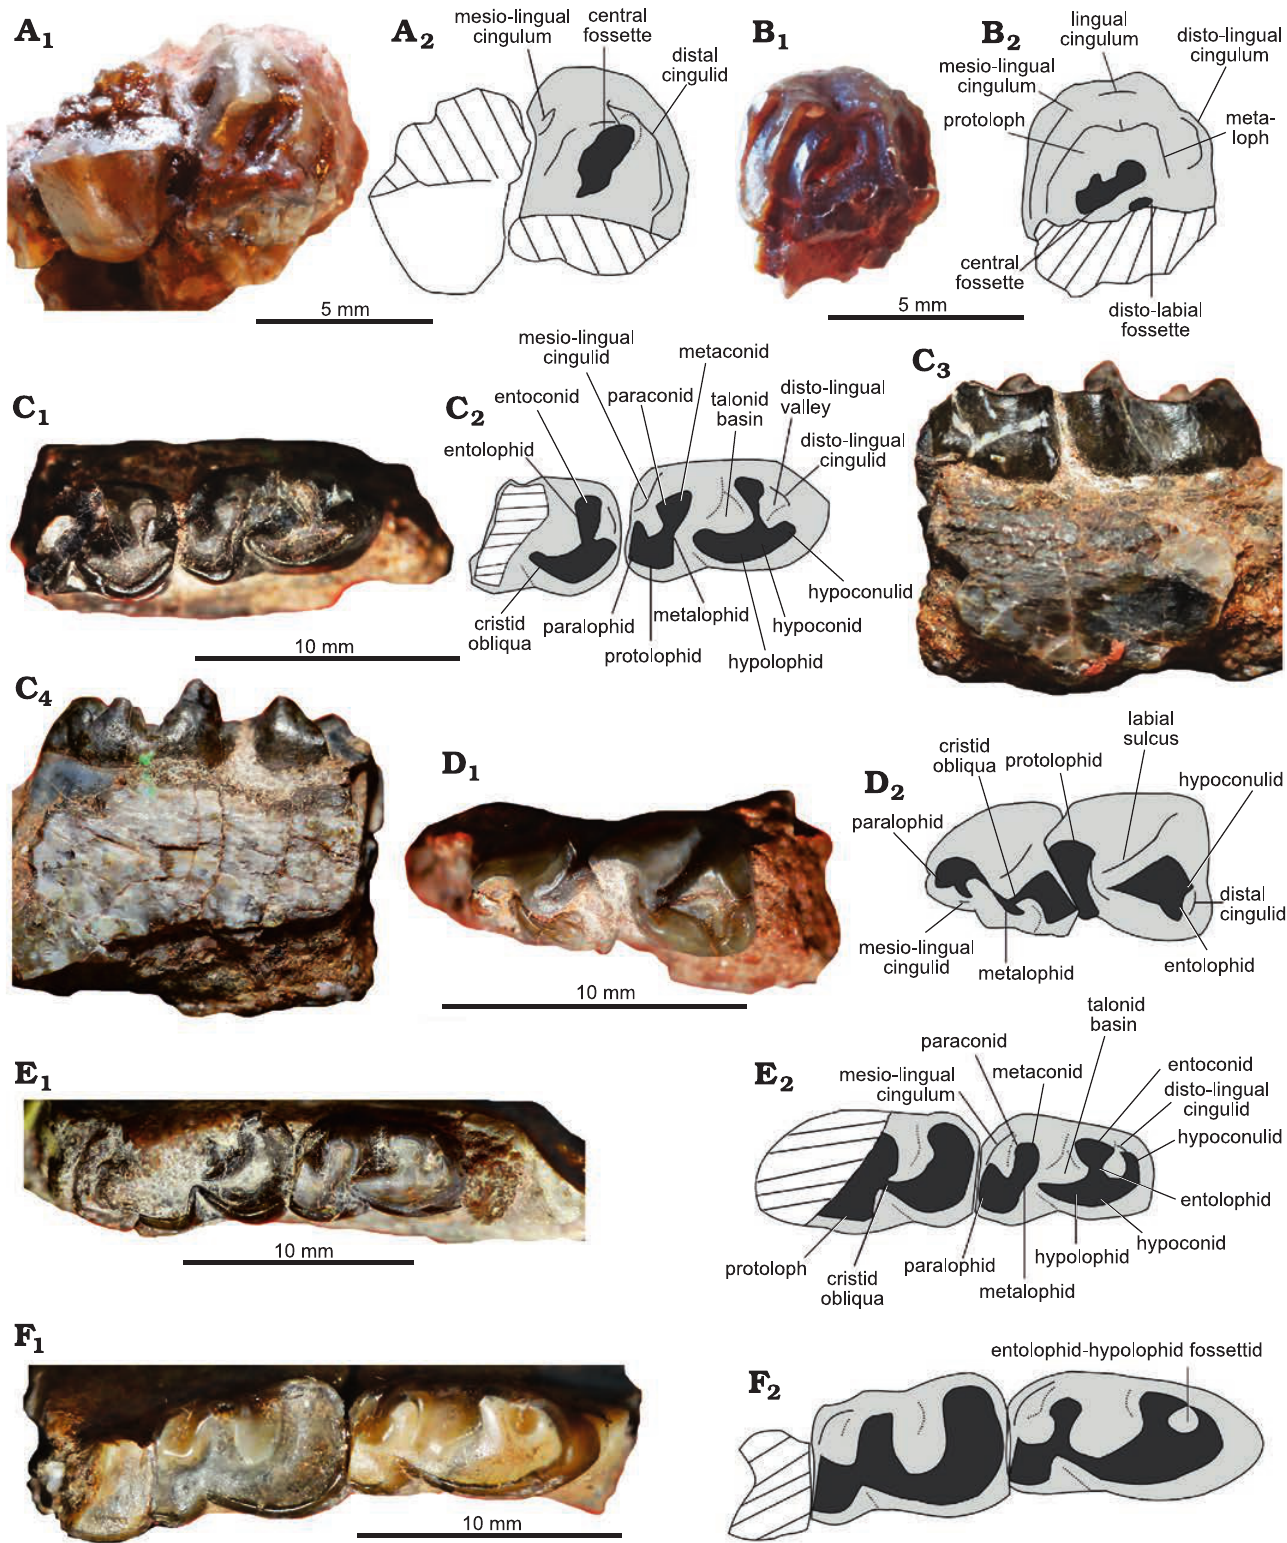
P4 and M3 in occlusal view. B . IBIGEO-P 56, broken right M1 or M2 in occlusal view. C – F . Colbertia falui sp. nov. C . IBIGEO-P 67, left mandibular fragment with m2–m3 (holotype) in occlusal (C 1 ), labial (C 3 ), and lingual (C 4 ) views. D . IBIGEO-P 55, right mandibular fragment with p3–p4 in occlusal view. E . IBIGEO-P 59, left mandibular fragment with m2–m3 in occlusal view. F . IBIGEO-P 61, left mandibular fragment with m1 (talonid)–m3 in oc- clusal view. Photographs (A 1 , B 1 , C 1 , C 3 , C 4 , D 1 , E 1 , F 1 ), explanatory drawings (A 2 –F 2 ). Dashed area indicates broken or missing dental